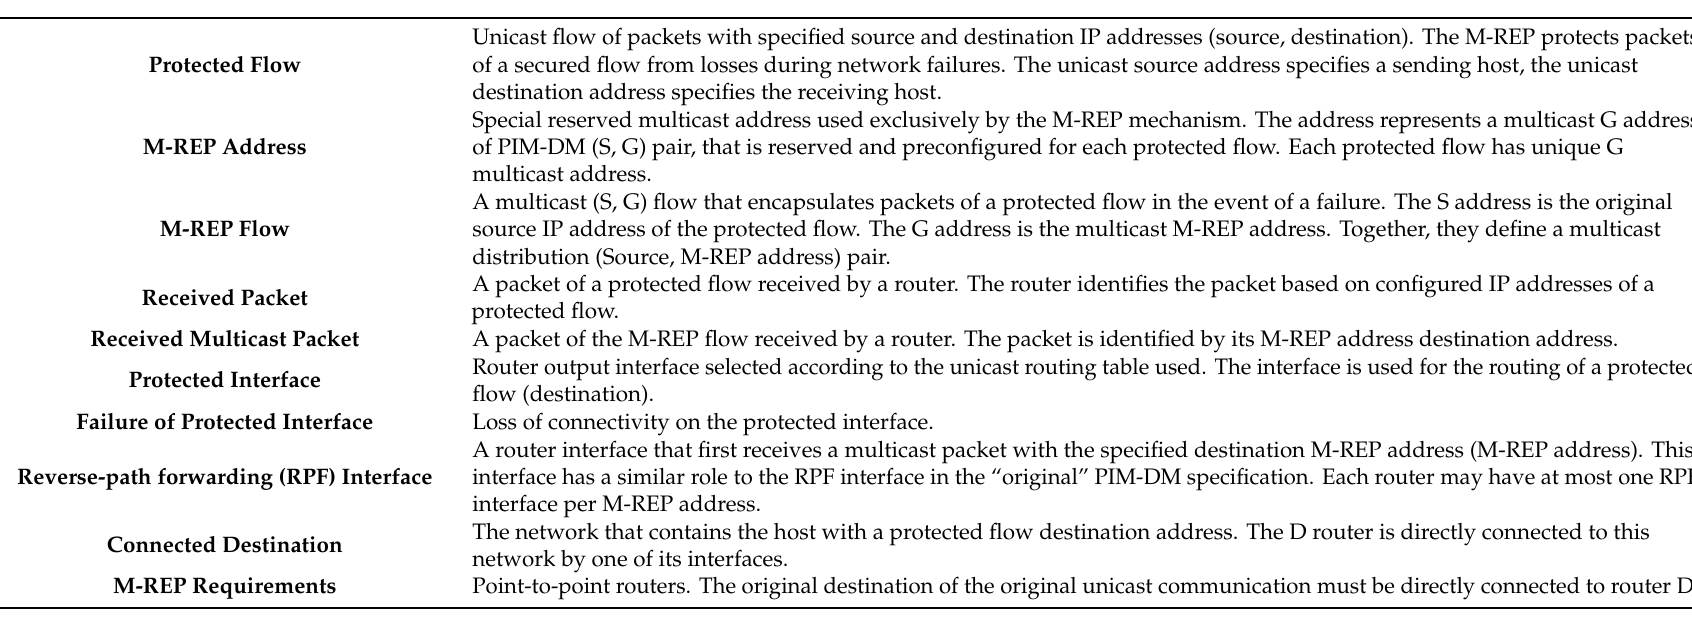
Table 2. Terminology used by the Multicast Repair (M-REP)